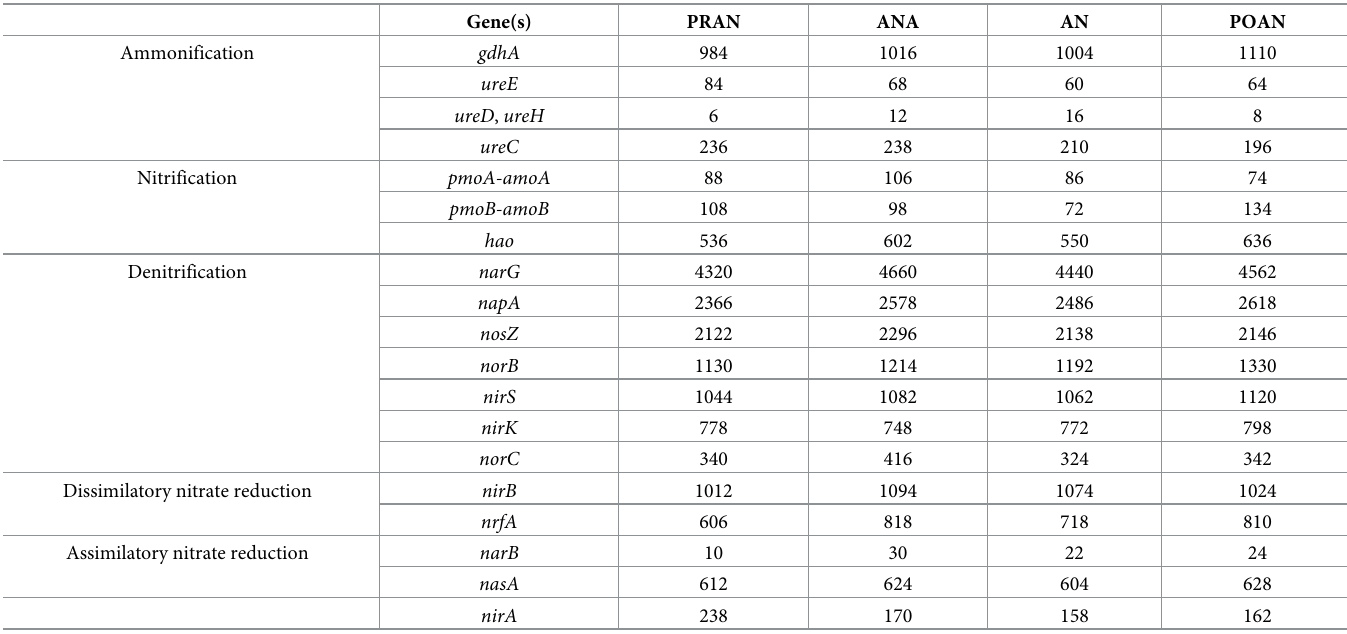
Table 3. The abundances of genes related to nitrogen